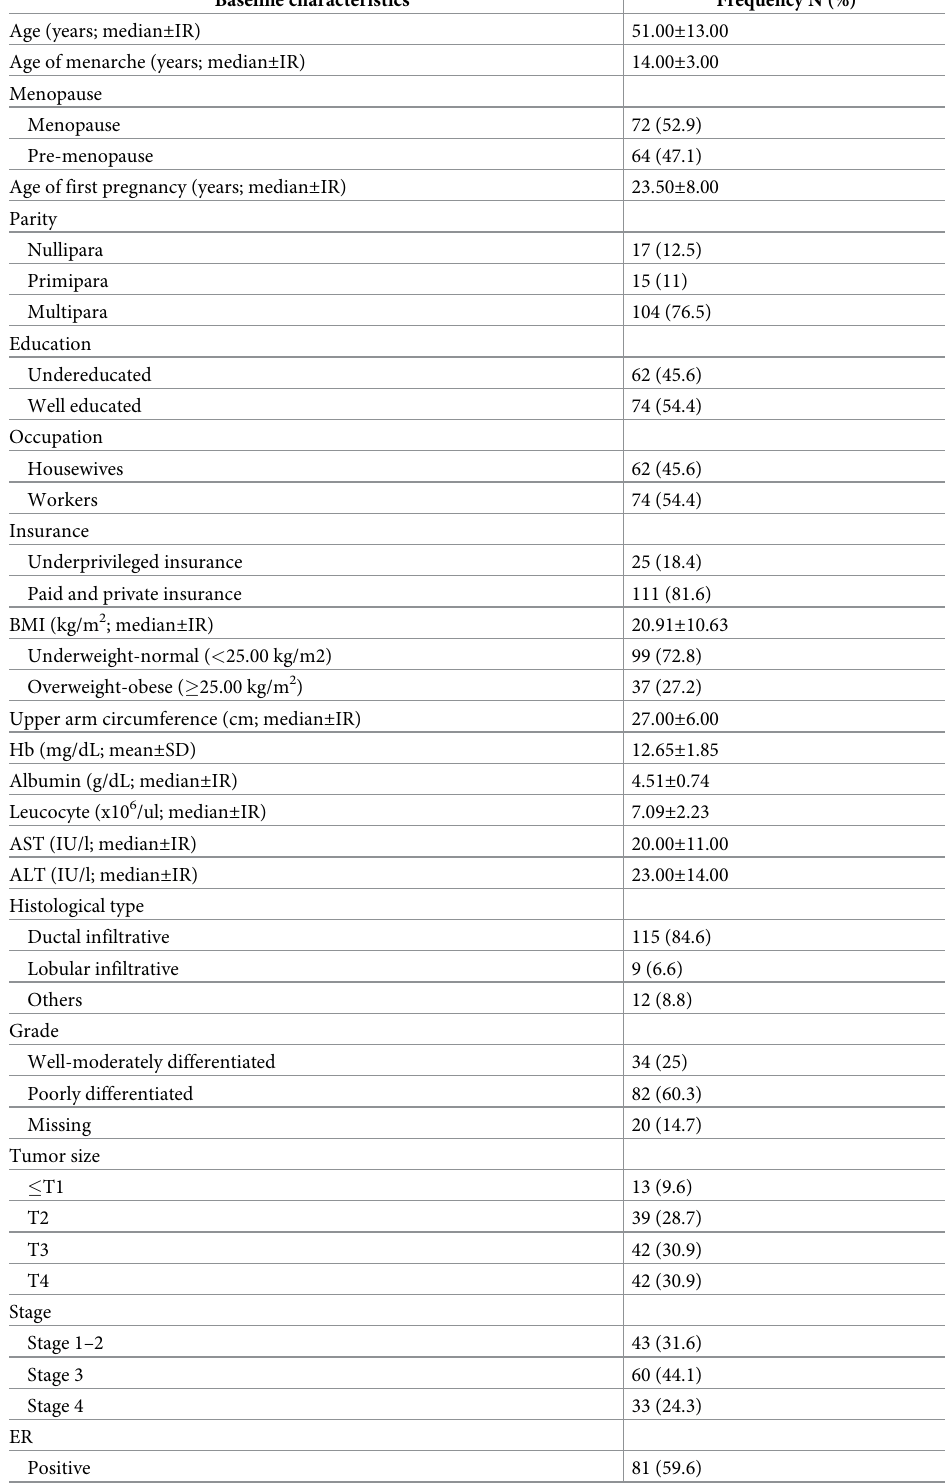
Table 1. Baseline characteristics of study subjects (n =